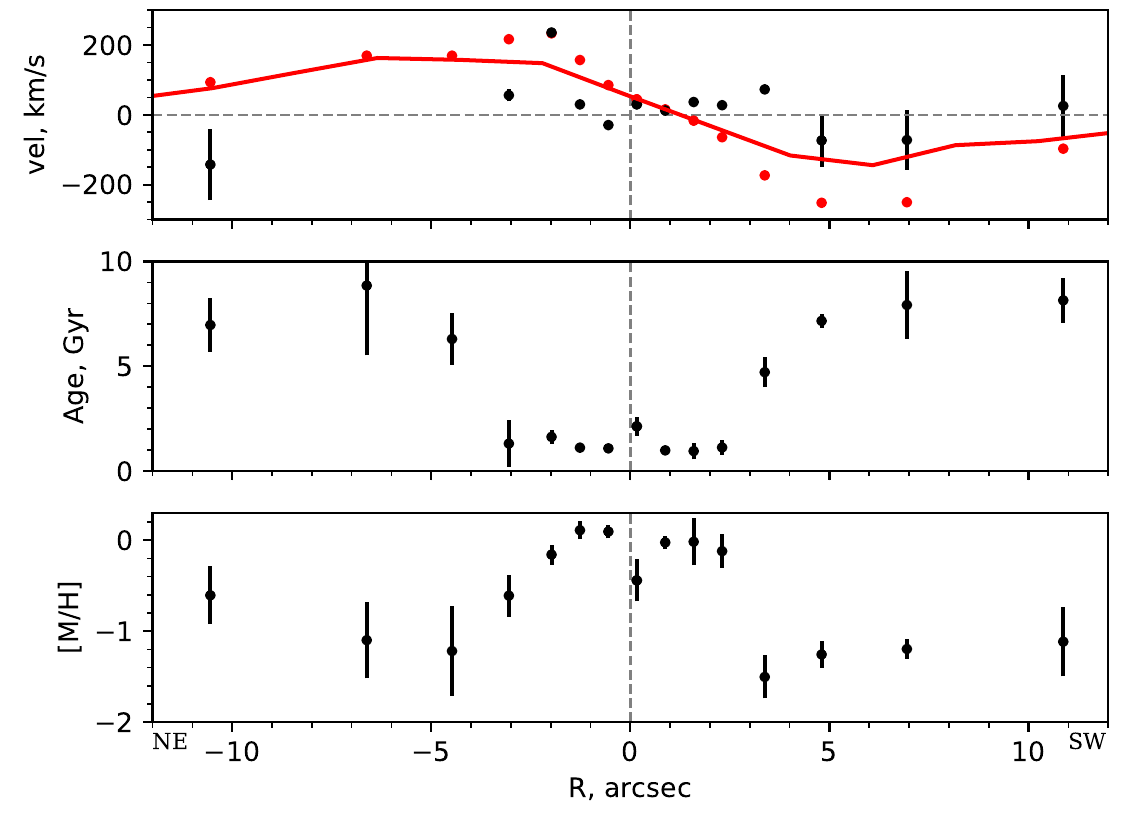
Figure 3. Gas/stars kinematics and stellar population properties derived from SCORPIO-2 observa- tions at PA = 60 ◦ . From top to bottom: line-of-sight velocity distribution for stars (black dots) and ionized gas (red), the red line shows the velocities in this direction according to FPI data, the systemic velocity 25,482kms − 1 was subtracted; radial distribution of the SSP age; the same for the stellar